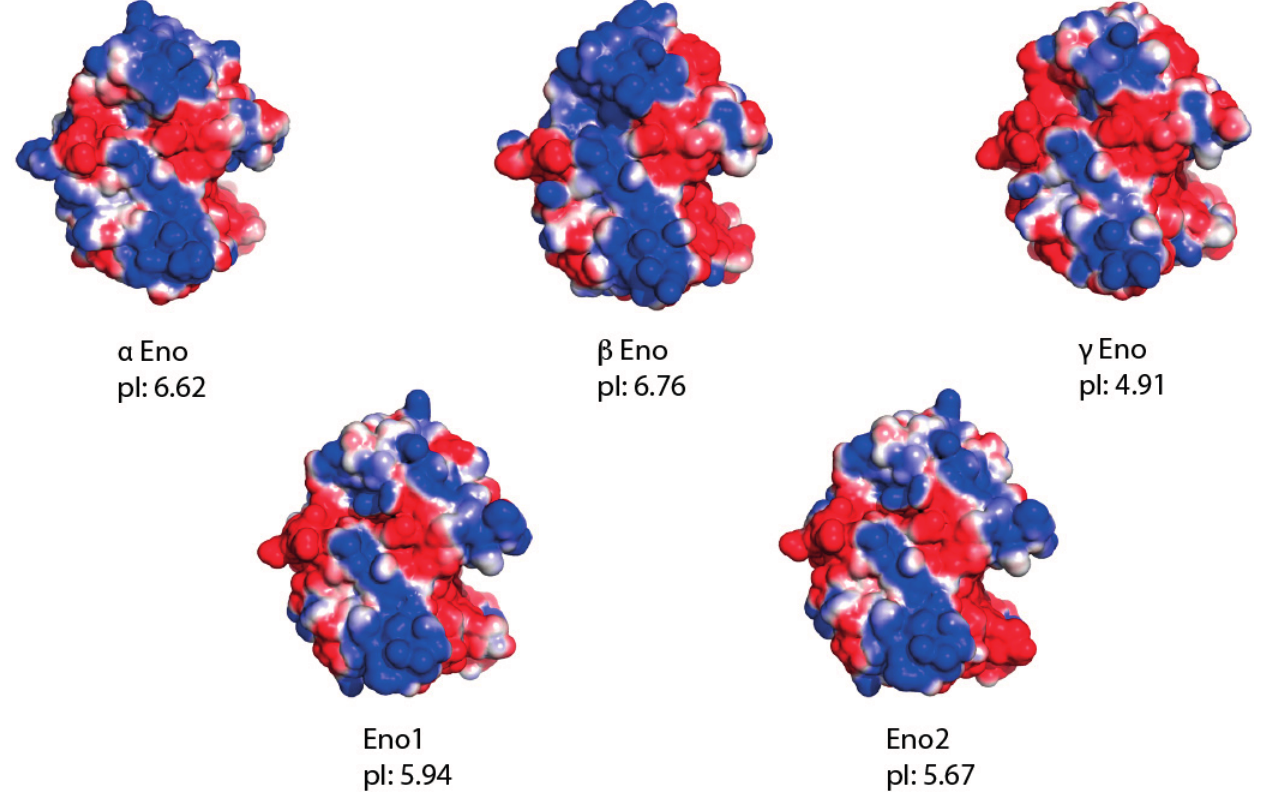
Figure 6. Electrostatic surface potentials visualized from the dimerization interface, corresponding to the region showing the highest density of positively charged residues, which may be responsible for tRK1 binding. Theoretical isoelectric points (pI) are also